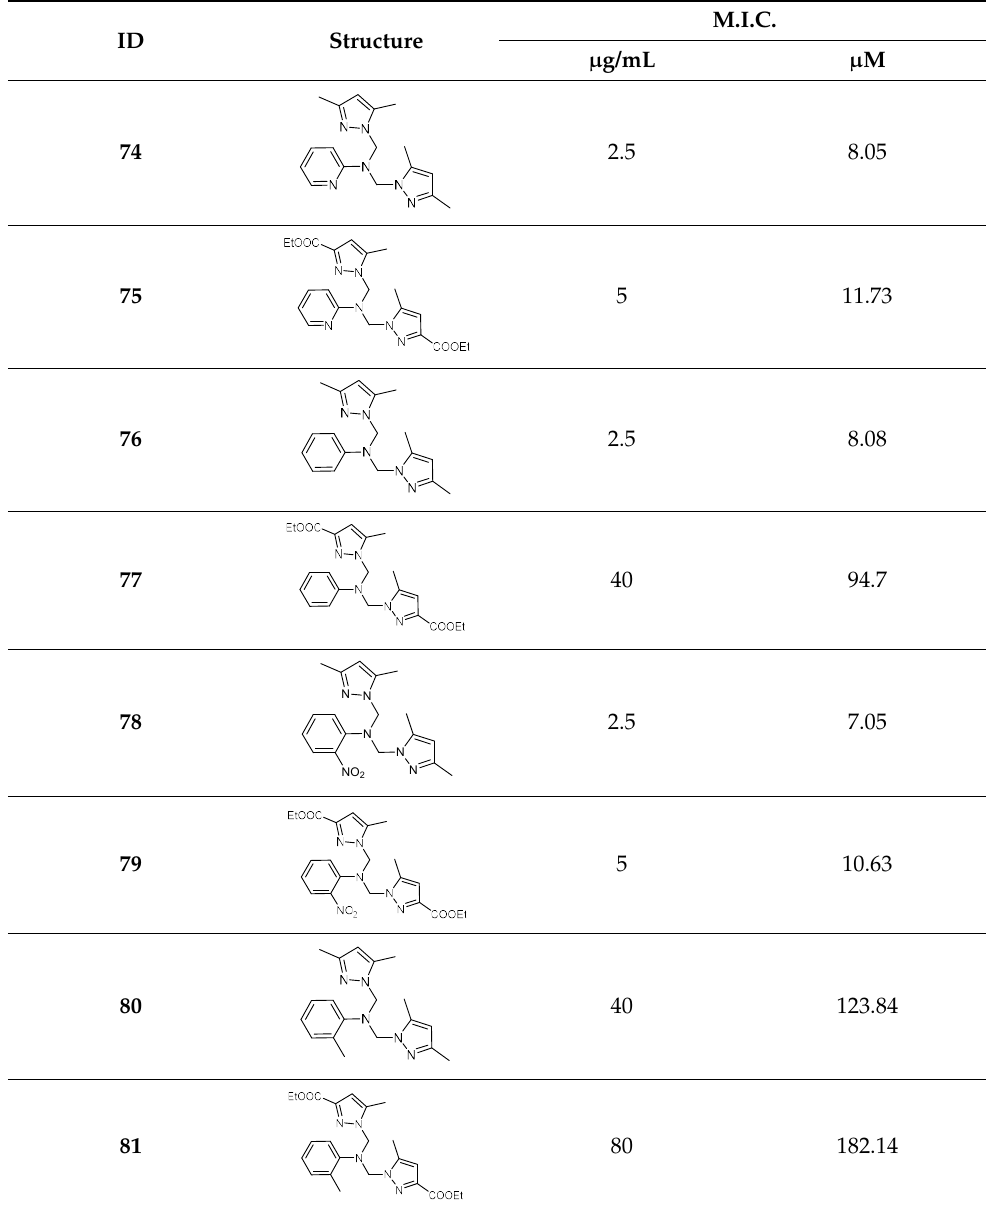
Table 10. M.I.C. values of bipyrazolic tripodal compounds tested against F.o.a.